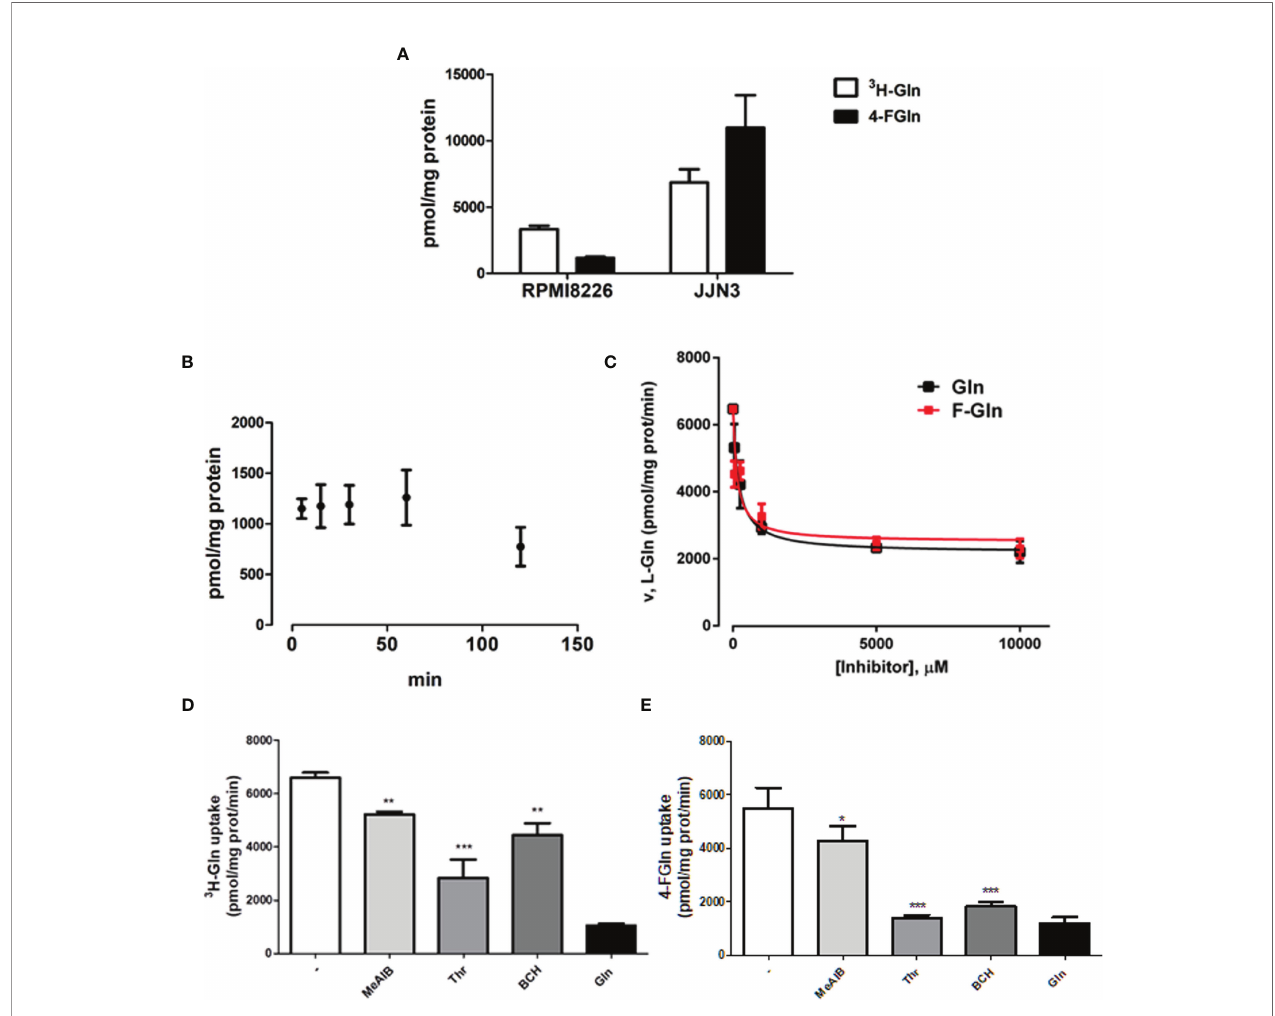
FIGURE 1 | Gln and F-Gln accumulation and uptake in MM cells. (A) RPMI8226 and JJN3 cells were incubated in EBSS containing L-[3,4- 3 H(N)]-Gln (0.1 mM, 2 µCi/ml, 3 H-Gln) or 4-FGln (0.1 mM) for 5 min. Means ± SD of two experiments with fi ve independent determinations each are shown. (B) RPMI8226 cells were incubated in EBSS containing 4-FGln (0.1 mM) for 5, 15, 30, 60, and 120 min. Means ± SD of two experiments with fi ve independent determinations each are shown. (C) RPMI8226 cells were incubated for 30 s in EBSS containing L-[3,4- 3 H(N)]-Gln (0.1 mM, 2 µCi/ml) in the presence of increasing doses (0.050, 0.25, 1, 5, or 10 mM) of cold 4-FGln or Gln. Means ± SD of two experiments with fi ve independent determinations each are shown. (D – E) 1-min 4-FGln (D) or Gln (E) uptake in RPMI8226 cells in the presence of the indicated inhibitors, used at 5 mM. Means ± SD of two experiments with fi ve independent determinations each are shown. *p < 0.05, **p < 0.01, ***p < 0.001. as assessed with a two-tailed t